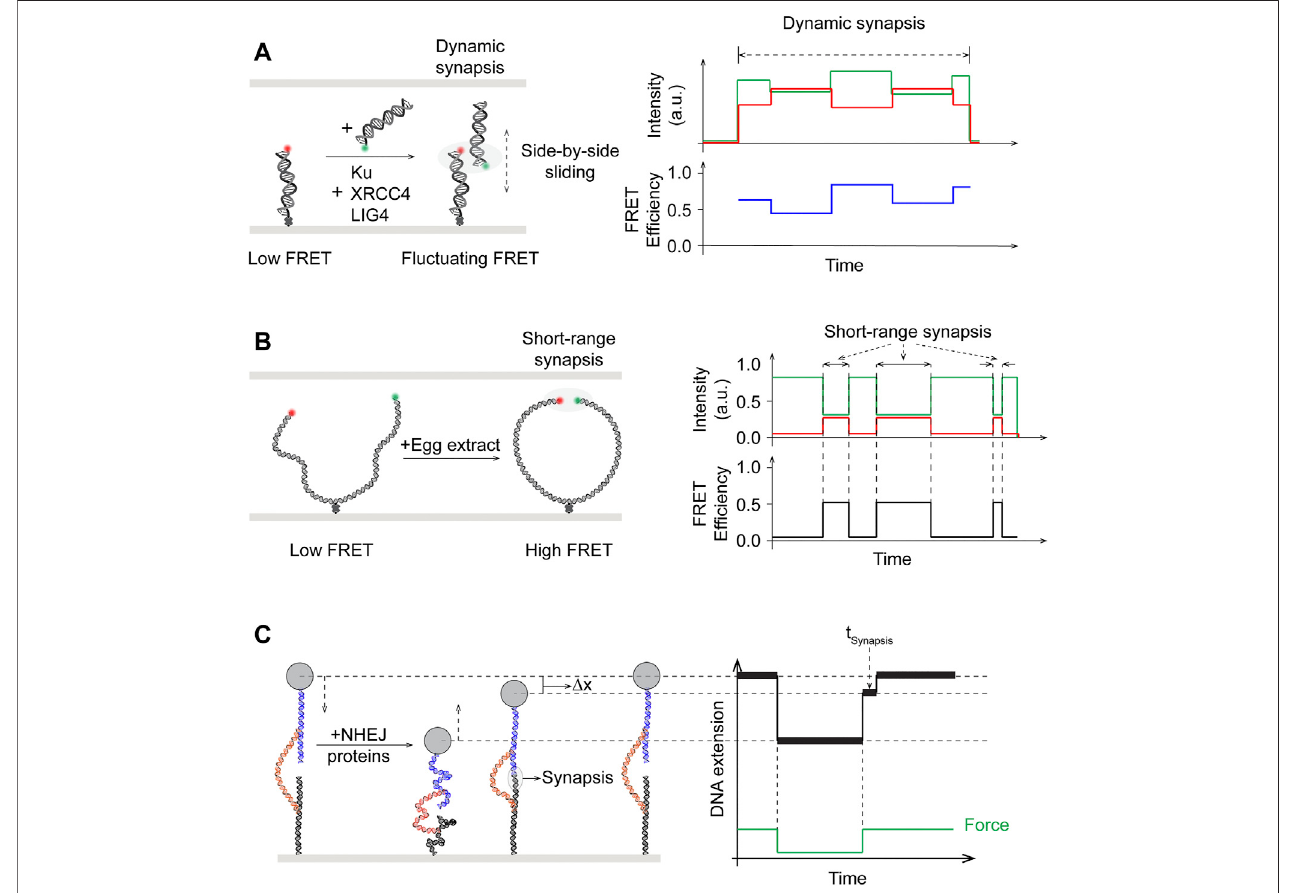
FIGURE 6 | Single-molecule studies of end synapsis in NHEJ. (A) Left: Schematics of intermolecular smFRET showing synapsis upon addition of puri fi ed human Ku,XRCC4,LIG4,butintheabsenceofDNA-PKcs,tobedynamicwith fl uctuatingandwidelydistributedFRETef fi ciency,suggestingthatthetwobrokenendsmayslide relative to and past each other during synapsis. Right: Side-by-side sliding of the donor with respect to the acceptor could give rise to the fl uctuating FRET ef fi ciency values. (B) Left: Schematics of intramolecular smFRET used to monitor end synapsis mediated by NHEJ factors in egg extract. Right: Distinct high FRET state reverted back to low FRET state, showing short-range synapsis was dynamic. (C) Magnetic tweezers with novel DNA substrate design tracks DNA extension and enables measuring dwell times ( Δ t ) of transient synapsis, by cycling between low force/extension that allows formation of synaptic complex and high force/extension to disrupt synapsed but unligated ends. A change in DNA extension ( Δ x ) at the same high force is observed when the synapsed ends are disrupted.